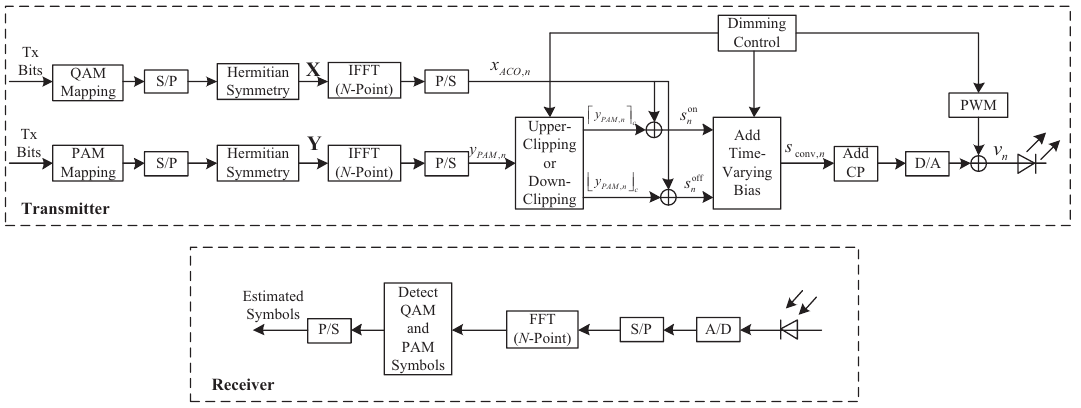
Figure 3. Block diagram of the transmitter and receiver for the proposed